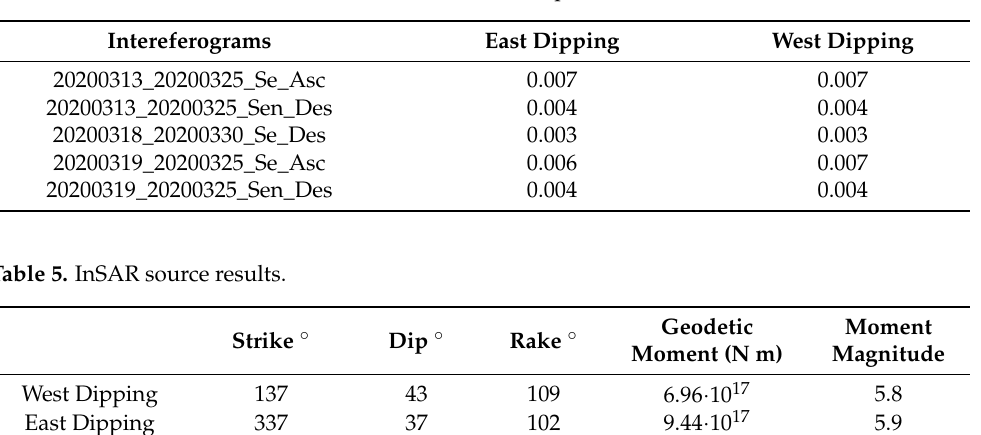
Figure 5. The same with Figure 4, but for a west-dipping fault. Table 4. RMS InSAR Linear Inversions for the two nodal planes examined.